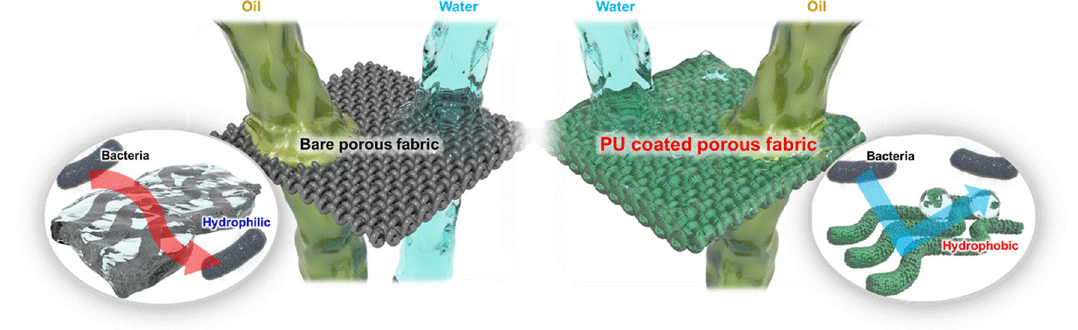
Fig. 1 Highly durable and sustainable heterogeneous fabric with in-and-out coatings. Schematic illustration of the in-and-out fl uorinated polyurethane (F-PU)-coated fabric for oil – water separation and bacterial penetration blocking.